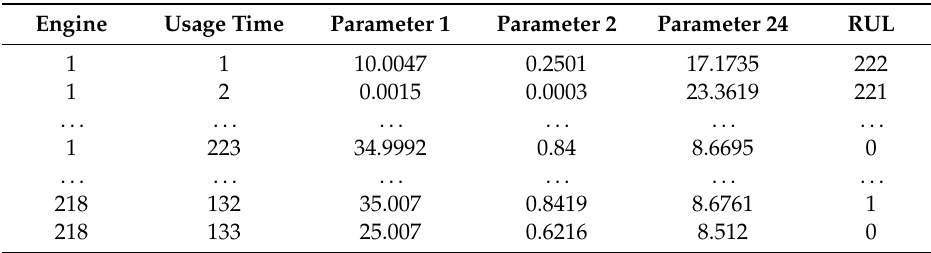
Table 1. Definition of Remaining Useful Life